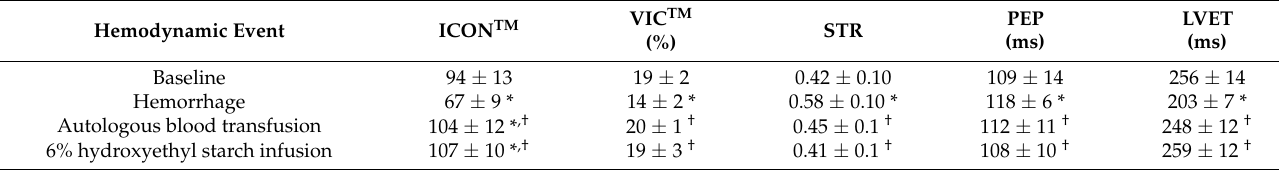
Table 3. Mean ± SD for contractility index (ICON™), variation in contractility (VIC™), systolic time ratio (STR), pre-ejection period (PEP), and left ventricular ejection time (LVET) measurements recorded using electrical cardiometry in six healthy, isoflurane-anesthetized Beagle dogs during four hemodynamic events: (1) baseline; (2) withdrawal of 30 mL/kg blood volume inducing hemorrhage; (3) autologous blood transfusion; and (4) 20 mL/kg 6% hydroxyethyl starch 130/0.4 in 0.9% sodium chloride solution. Since the values for ICON™, VIC™, STR, PEP, and LVET for the five timepoints under each event are not statistically significant, the mean ± SD values are calculated from the timepoint measurements to represent each